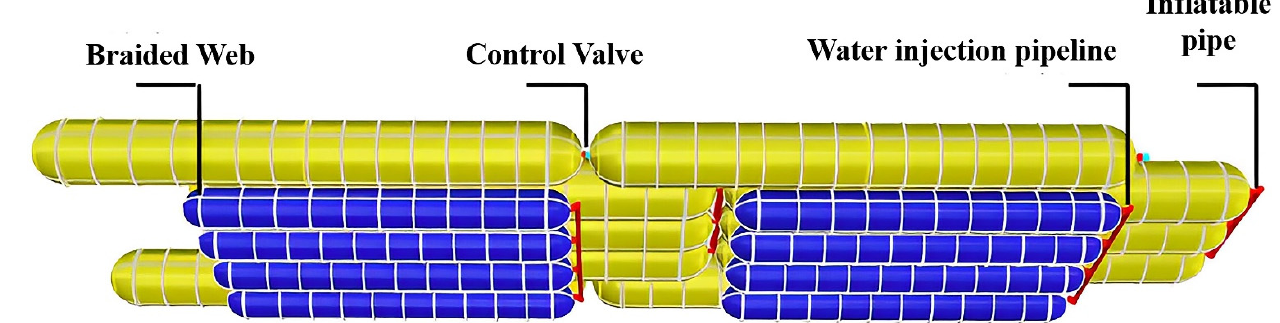
Figure 2. The overall structure of the airbag.